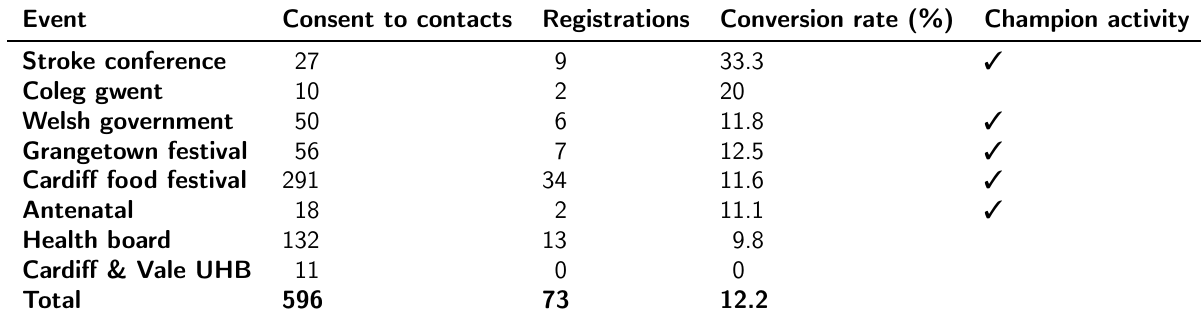
Table 1: Conversion rate from consent to contact forms to registered participants from events where HealthWise Wales was